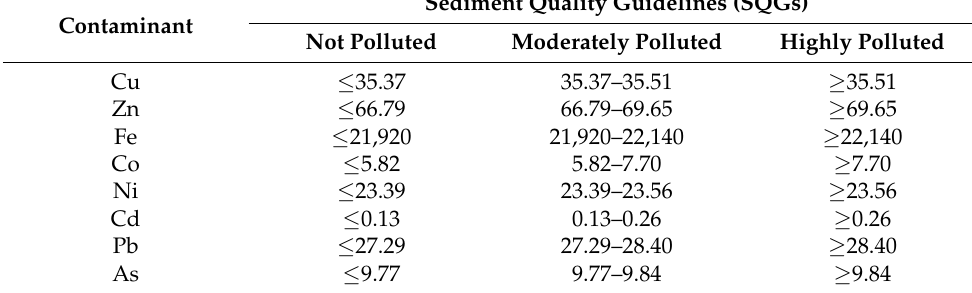
Table 3. Summary of calculated benchmark sediment quality guidelines (SQGs; mg kg − 1 dw) proposed to evaluate sediment quality in the Guadalquivir River course between the Alcal á del Rio and Seville for the metals Cu, Zn, Fe, Co, Ni, Cd, and Pb, and the metalloid as associated with toxic effects.